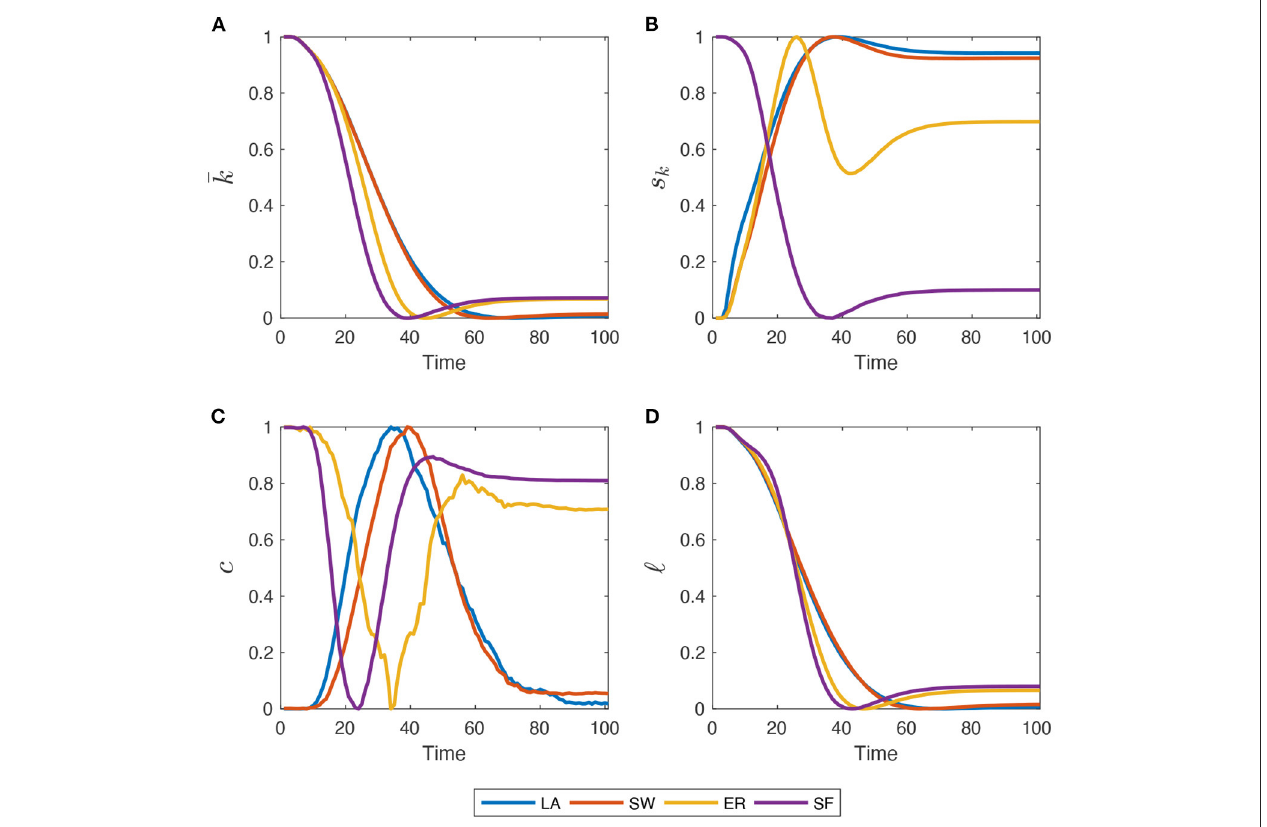
FIGURE 2 | Within-simulation evolution of network metrics, re-scaled to match the [0,1] interval. (A) Average Degree ( ¯ k ); (B) standard deviation of node degree distribution ( s k ); (C) global clustering coefficient ( c ); (D) average path-length ( ℓ ). Initial ¯ k = 8 for all four graph families. Mid-impact epidemic scenario. Averages across M = 1,000 Monte Carlo